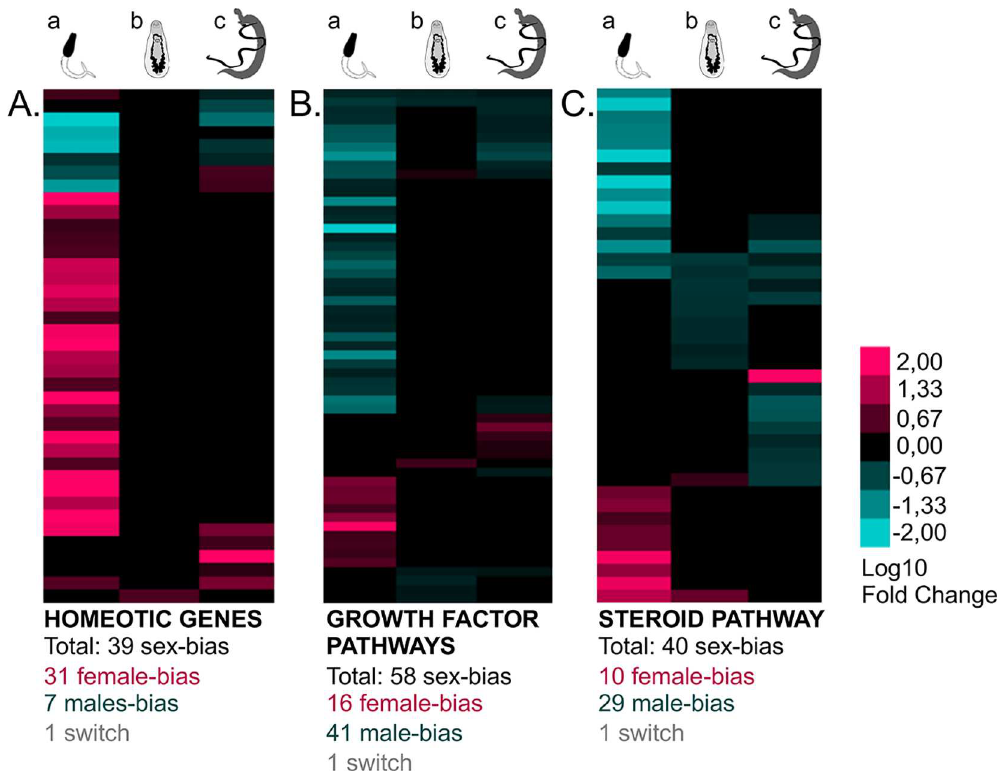
Fig 4. General clustering of sex-biased gene expression depending on their “general developmental pathway” functional category. Male-biasesare representedin blue, female-biases in pink and non-significant differences (Padj > 0.05) in black. Three stages are considered: (a) cercariae, (b) schistosomula s#2 and (c) adults. (A) 39 homeotic genes are mainly female-biased in cercariae. (B) 58 genes linked to growth factor pathways are mainly male-biasedin cercariae and adults. (C) 40 genes are related with the steroid pathway and are mainly male-biased through the three stages. The functional annotationand details on gene expression are provided in S6